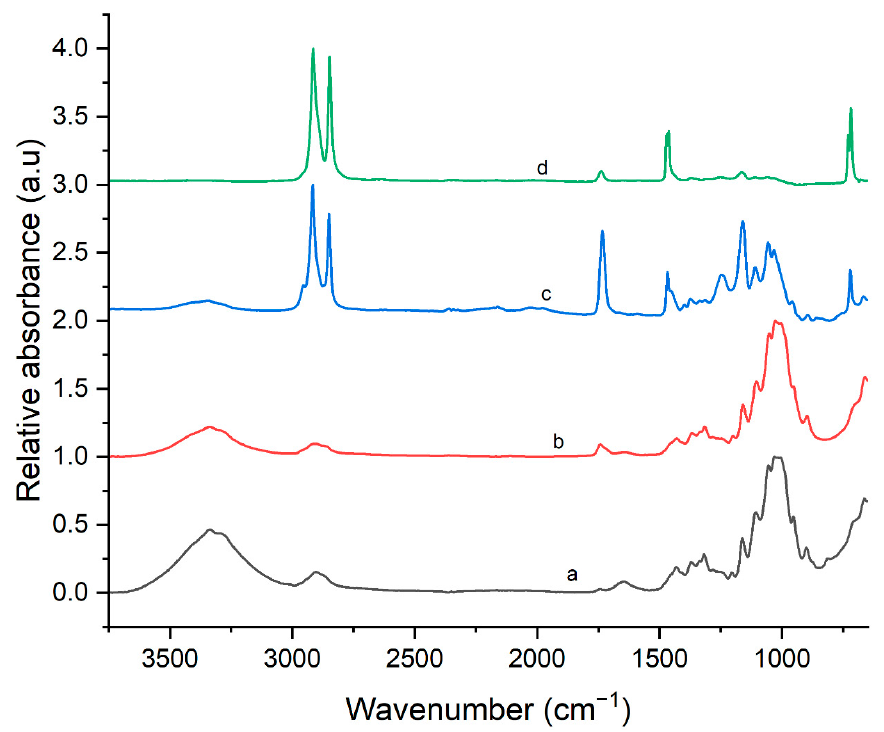
Figure 1. ATR-FTIR spectra of pristine CNF (a), CNF-MI (b), CNF-PSA (c) and CNF-PSA/HDPE composite (d).